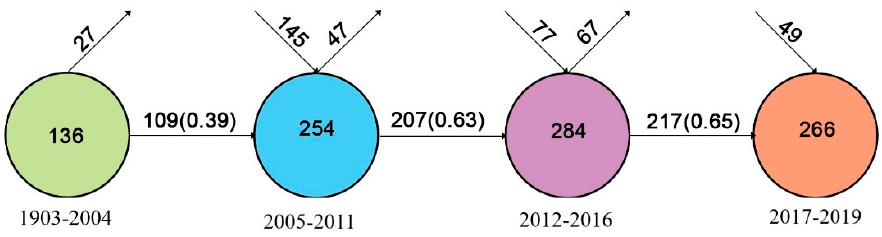
Figure 14. Overlapping-items graph of farmland abandonment research field from 1900 to 2019.